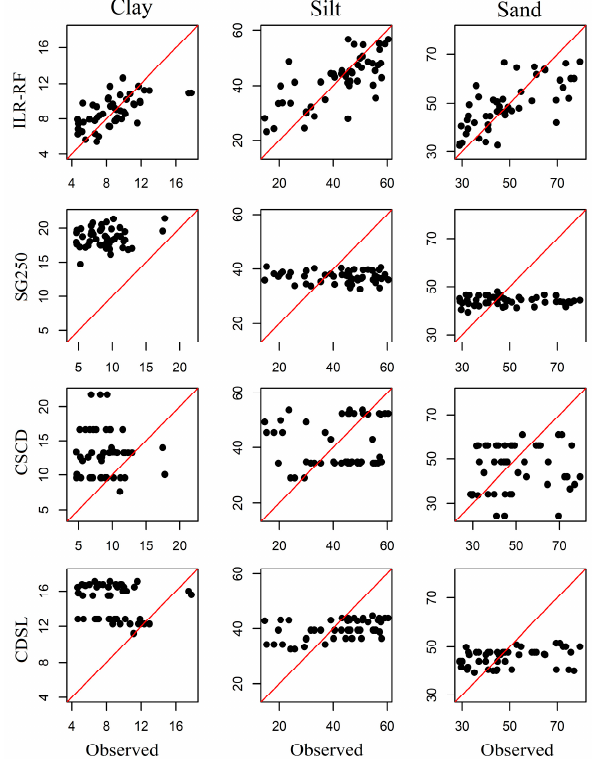
Figure 4. Comparison of soil particle size fractions at the Budongquan-Qingshuihe (BQ) region derived from four datasets.